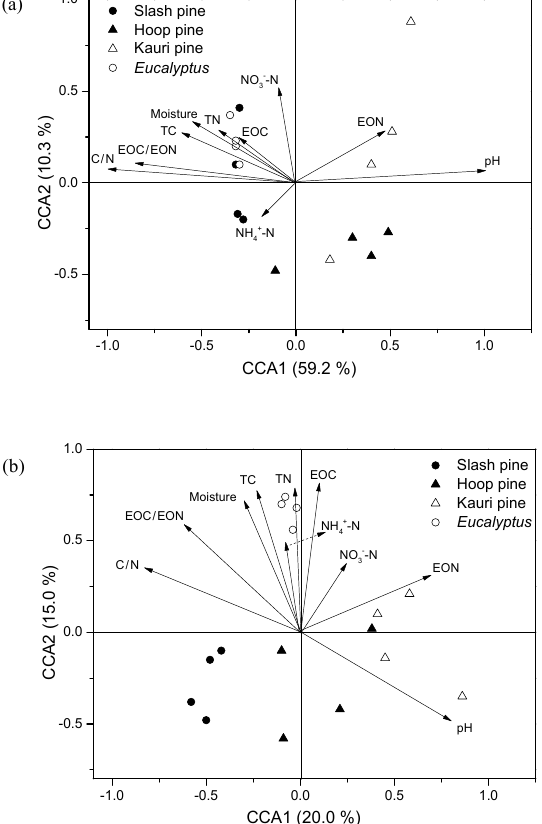
Figure 3. Most abundant eukaryotic phyla (a) and genera (b) in soils under different tree species.